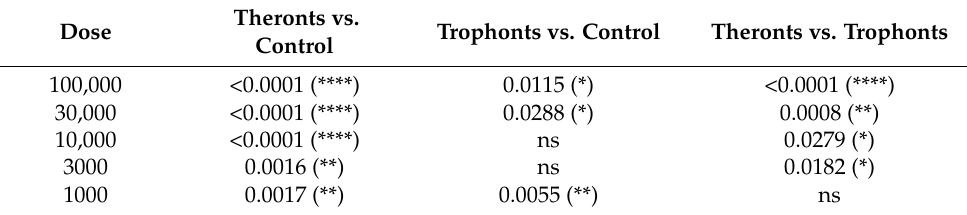
Table 1. Log rank analysis of difference between Kaplan–Meier survival plots of slugs exposed to doses of theronts, trophonts or untreated controls.